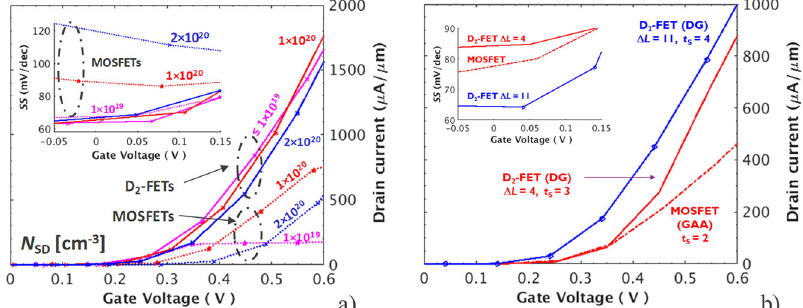
Fig. 11 L = 3 nm D 2 -FETs vs MOSFET transfer characteristics. I D ( V G ) characteristics and SS ( V G ) (inset) for a HfS 2 double gated nMOSFETs and nD 2 -FETs with Δ L = 4 nm vs N SD , and b optimized Si-GAA nMOSFETs ( N SD = 1 × 10 20 cm − 3 ) and DG nD 2 -FETs (intrinsic N SD ) for Δ L = 4 and 11 nm. For the D 2 -FETs the optimized fi lm thickness t S (also indicated in the fi gure in nm) is larger than for the MOSFET. V D = 0.6 V. L = 3 nm. I OFF = 10 nA/ μ m.